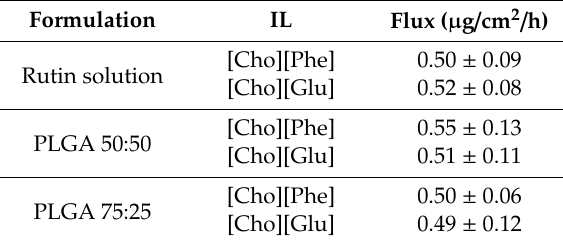
Table 3. Permeation flux of rutin IL solution, at 0.87 mg / mL for [Cho][Phe] and 0.37 mg / mL for [Cho][Glu], and rutin-loaded IL-polymer nanoparticle hybrid systems. Data represented as mean ± SD ( n =